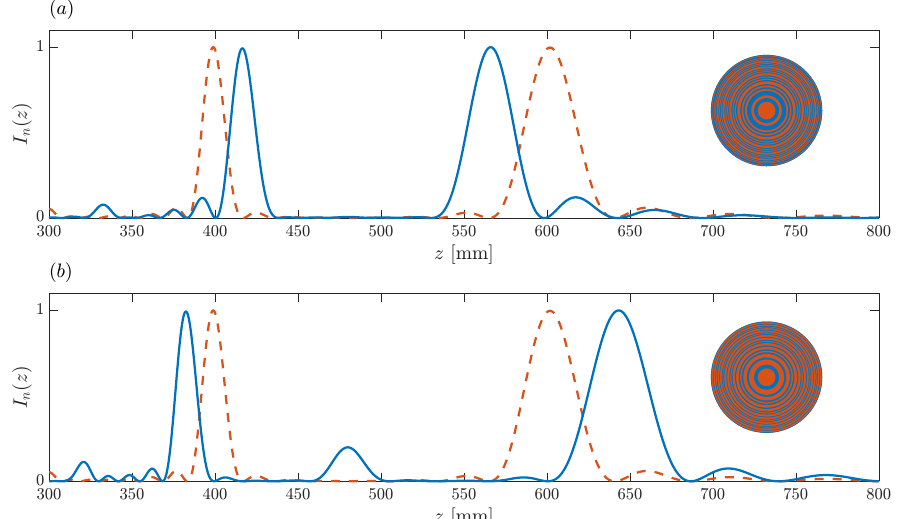
Figure 7. Bifocal ZP focusing profiles vs. axial coordinate. Blue solid line ( a ) u 1 = 24 and u 2 = 18 (inwards shift case), ( b ) u 1 = 26 and u 2 = 16 (outwards shift case). Dashed red line corresponds to the initial design example with u 1 = 25 and u 2 = 17. Insets depict the ZP layouts for the focusing profiles depicted in